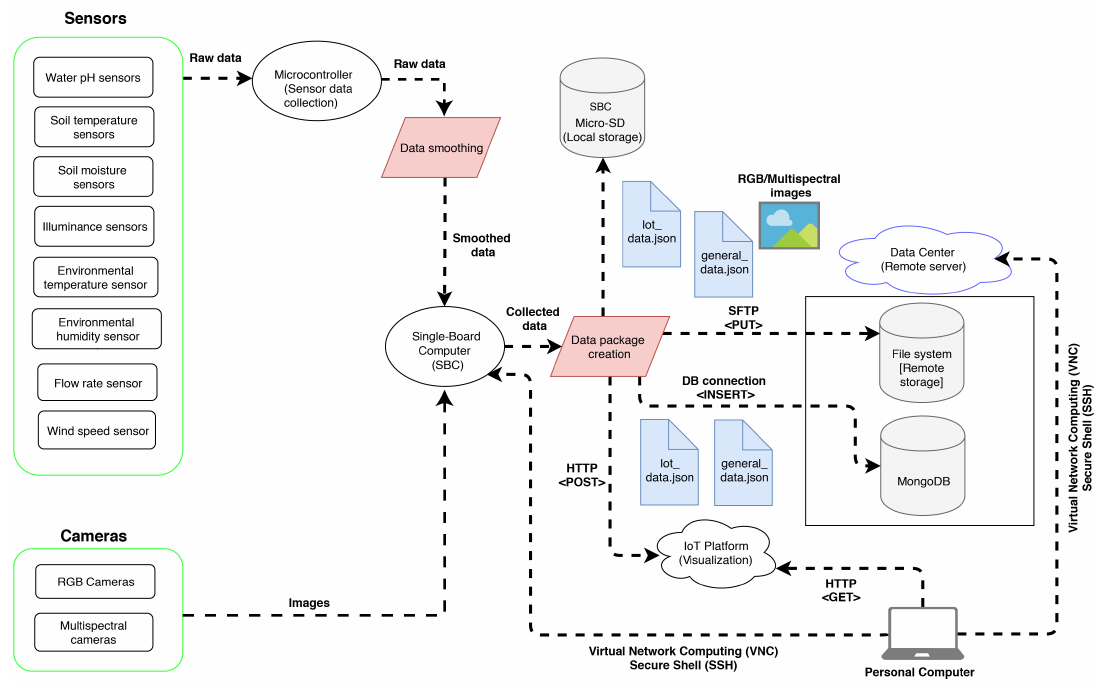
Figure 9. Data collection